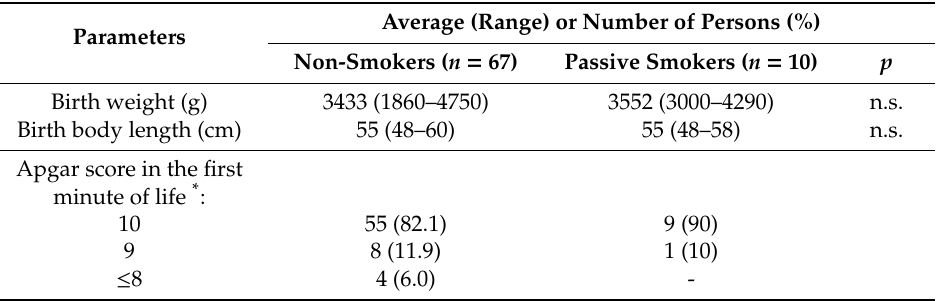
Table 5. Comparison of birth parameters of newborns of non-smoking and passive smoking mothers during